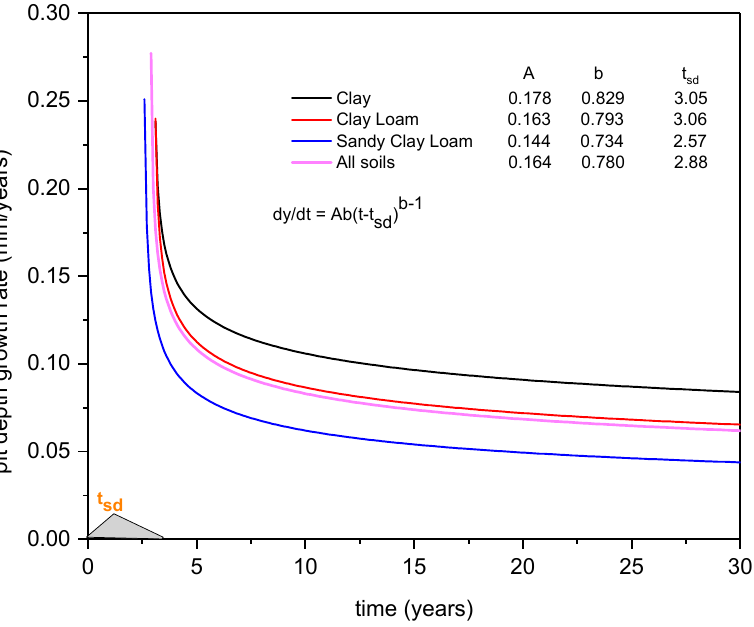
Figure 5. Evolution of pitting growth rate predicted for an average typical condition for soils in southern Mexico according to the study presented by Velázquez et al. adapted from [14].